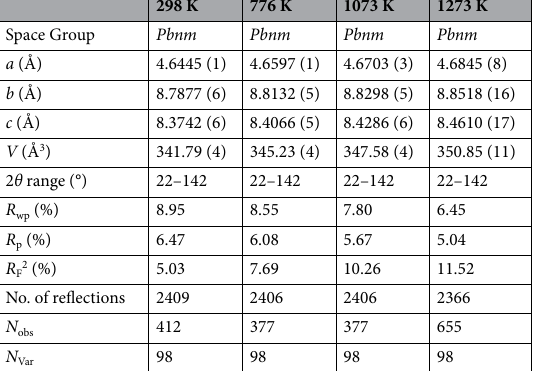
Table 2. Refinement details of the neutron data collection and unit cell parameters of topaz at 298, 776, 1073 and 1273 K. R